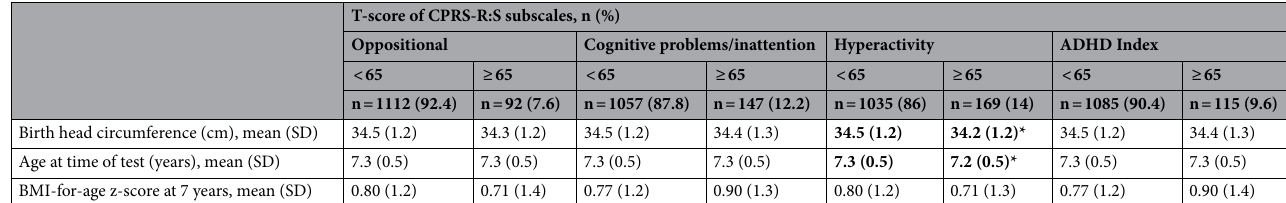
Table 1. General maternal and child characteristics according to children’s T-score categories of CPRS-R:S subscales at age 7 years. Values are expressed in mean (SD) or number (%) unless otherwise indicated. The differences between child T-scores of CPRS-R:S subscales as derived from Student’s t or chi-square tests, as appropriate. SD standard deviation, BMI body mass index, IQR interquartile range, CPRS-R:S Conners’ Parent Rating Scale-Revised Short Form, ADHD attention deficit hyperactivity disorder. Bold values denote a significant statistical test; *p-value < 0.05 or †p-value < 0.01. € FS measurements at first and second trimester as a whole were defined as first period of pregnancy. ⁋ n =